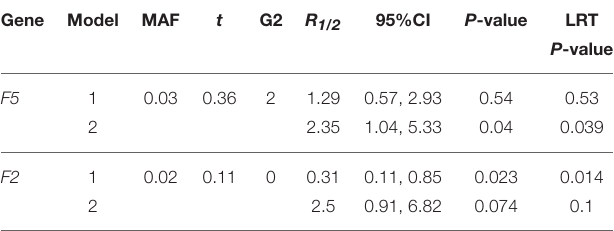
TABLE 5 | Relative risk With 95% CI, P -values, LRT P -values of models 1 (Unadjusted) and 2 (Adjusted) for 2 thrombopilic genes ( F5 and F2 ), with MAF, transmission ratio ( t ) and Number of Genotype 2 Cases (G2), on an intrauterine growth restriction dataset collected from a Canadian Hospital Between 1998 and